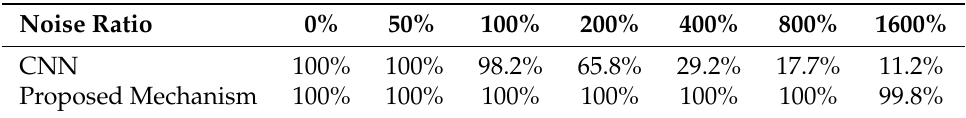
Table 4. Comparison of identification accuracy between CNN and proposed mechanism for 32 voxel